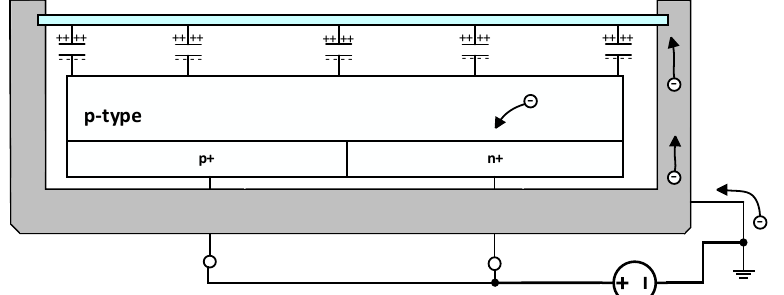
Figure 3. A cross-section of a p-type PV panel that is biased with the power converter where the regeneration is implemented.